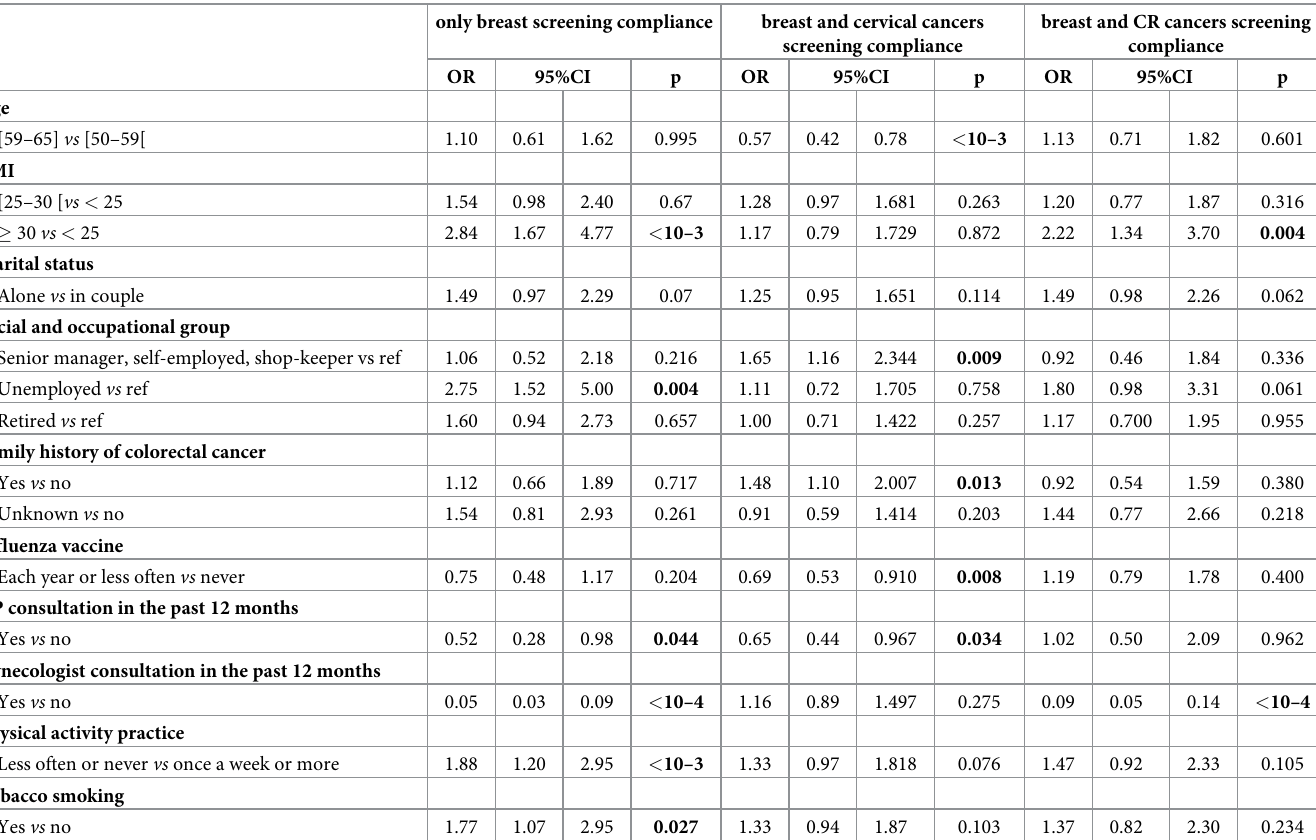
Table 4. Multivariate polytomic